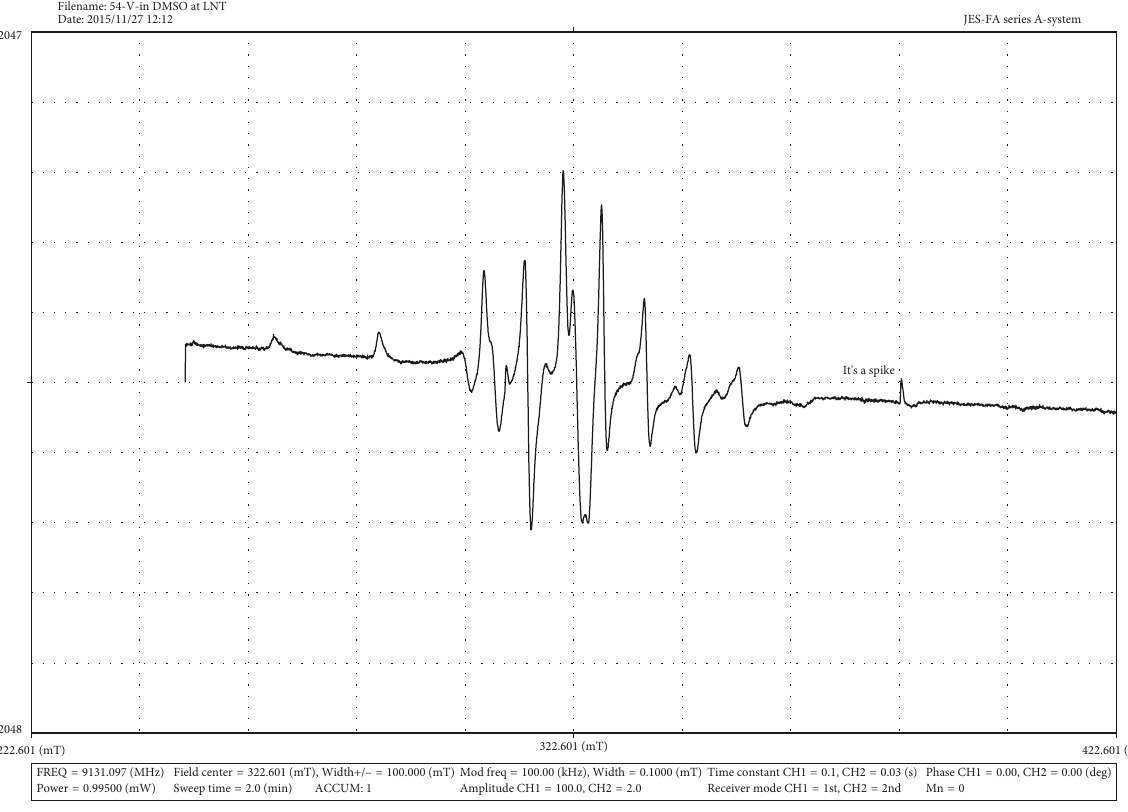
Figure 2: ESR spectrum of C 2 in DMSO at liquid nitrogen temperature. Table 4: ESR spectral data of oxidovanadium(IV) complexes in DMSO at liquid nitrogen